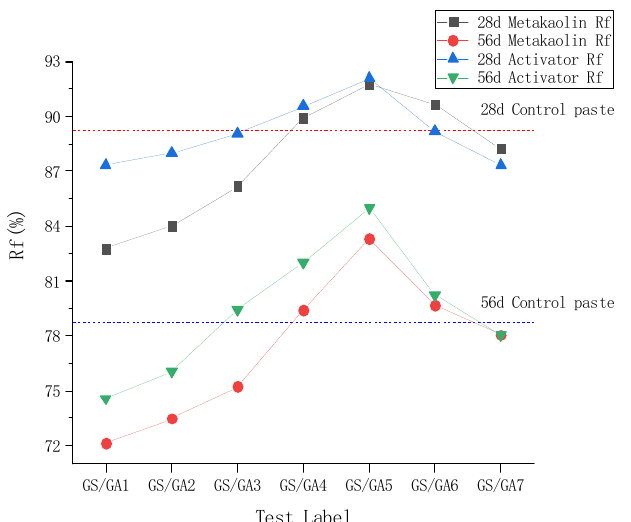
Figure 5. Compressive strength corrosion resistance coefficients of GS/GA and cement control pastes.